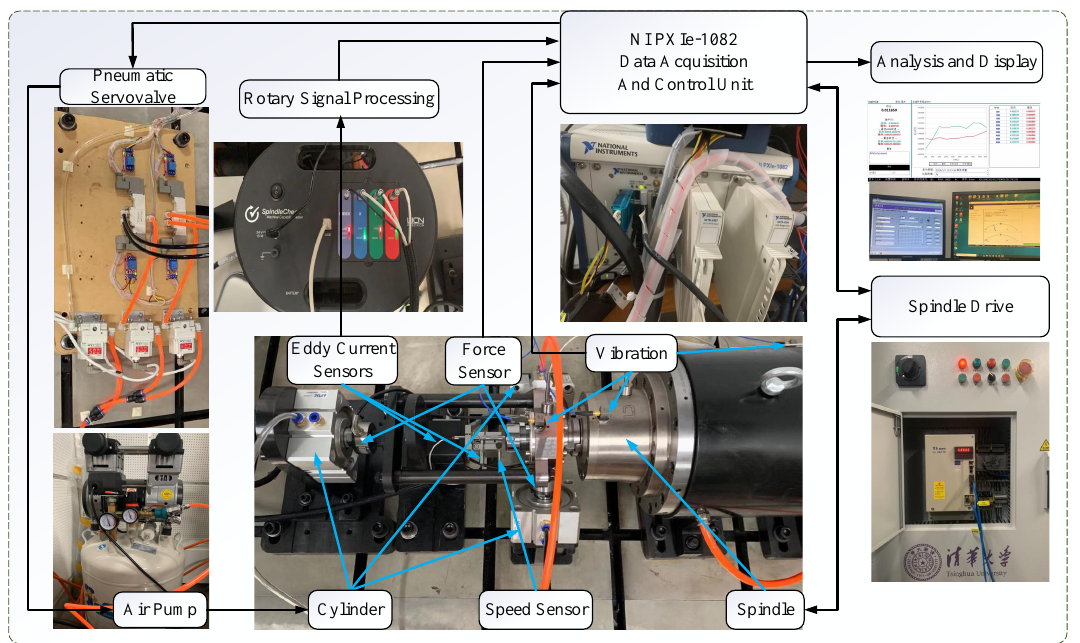
Figure 8. The spindle experimental platform.